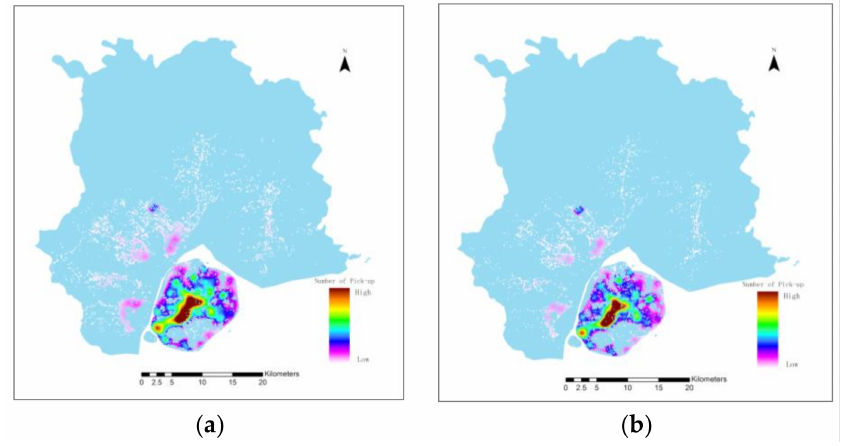
Figure 6. Kernel density analysis of the pickup number ( a ) and drop-off number ( b